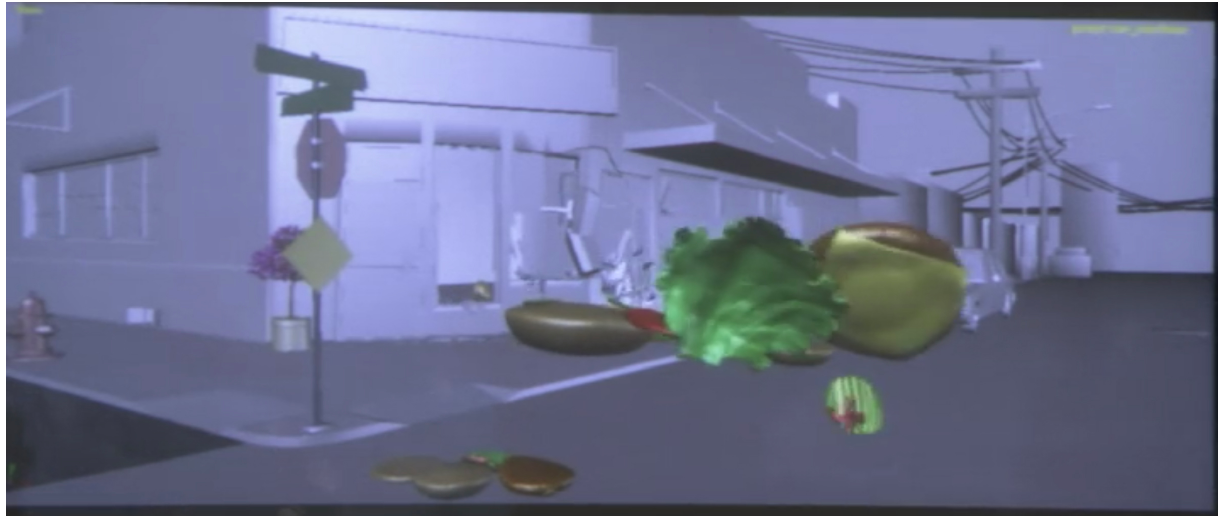
Figure 5: Animators test the trajectory of a falling burger (A Recipe for